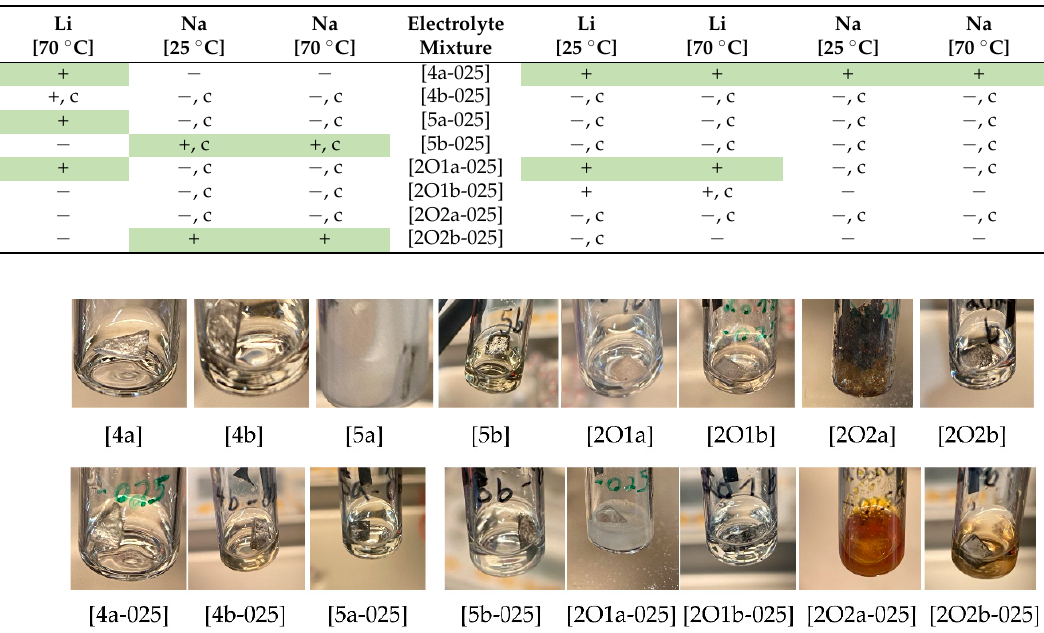
Figure 2. Images of the stored electrolytes (28 d) over lithium metal at 25 ◦ C. a = [TFSI] − , b = [FSI] − .